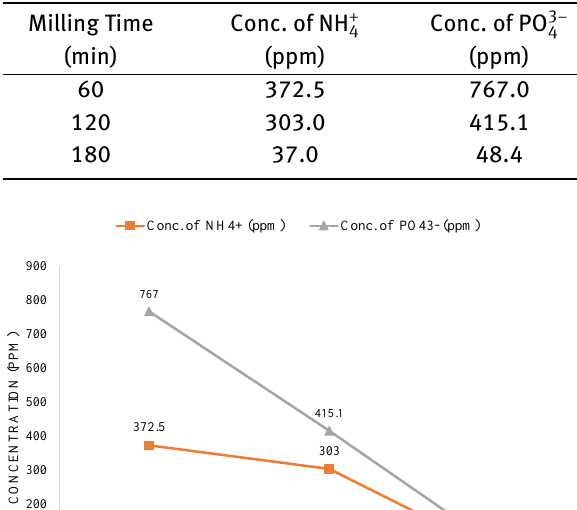
(kaolin–(NH 4 ) 2 HPO 4 samples when distributed in water for 24 hours as a function of mill rotational speeds.